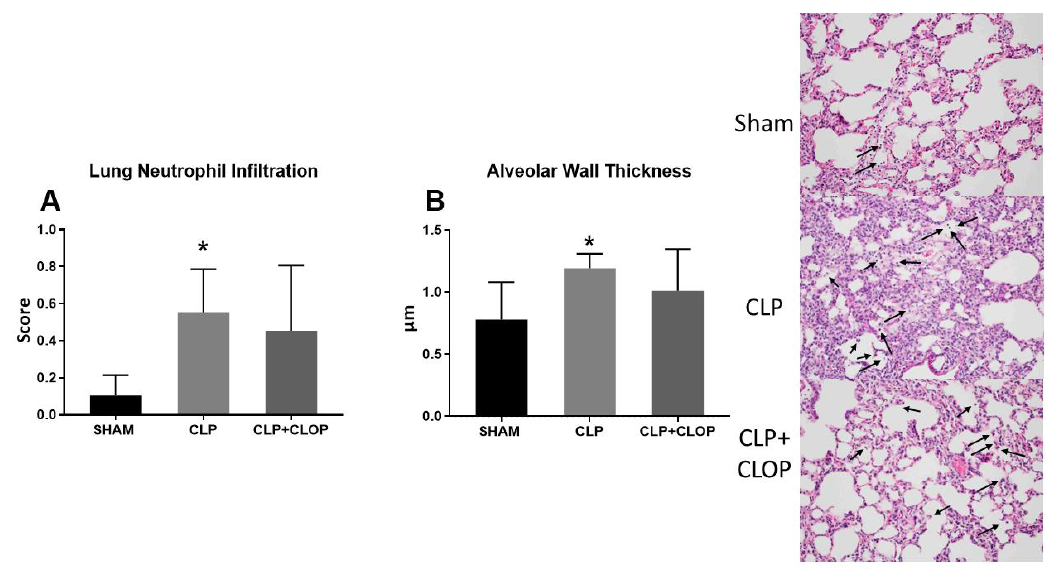
Figure 5. Lung injury. Neutrophil Infiltration ( A ) and alveolar wall thickness ( B ) into pulmonary tissues were assessed in Sham, CLP, and CLP + CLOP. H&E staining was performed on paraffin-embedded lungs from Sham, CLP, and CLP + CLOP rats (Representative images) ( n = 6/group). Black arrows indicate neutrophil infiltration. * p < 0.05 vs. Sham.